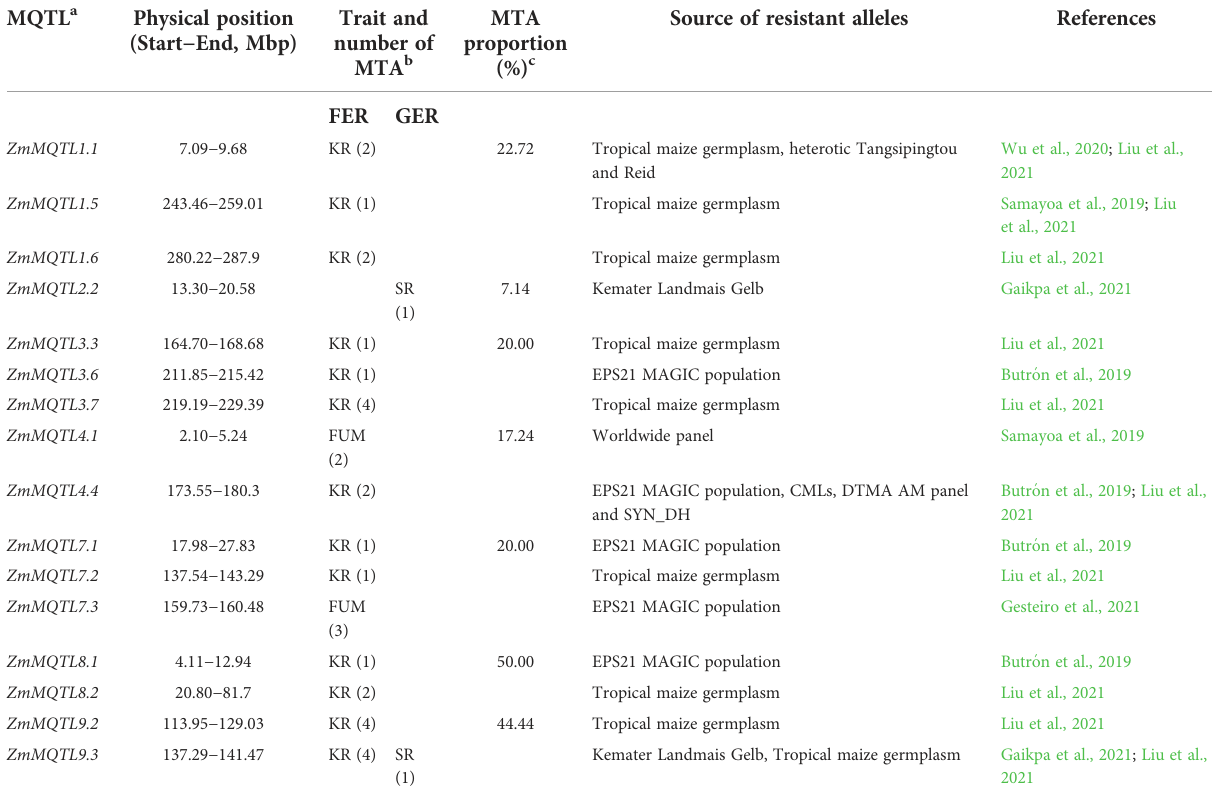
TABLE 6 Number of marker-trait associations (MTA) located within identi fi ed meta-QTL (MQTL). MQTL a Physical position (Start − End,